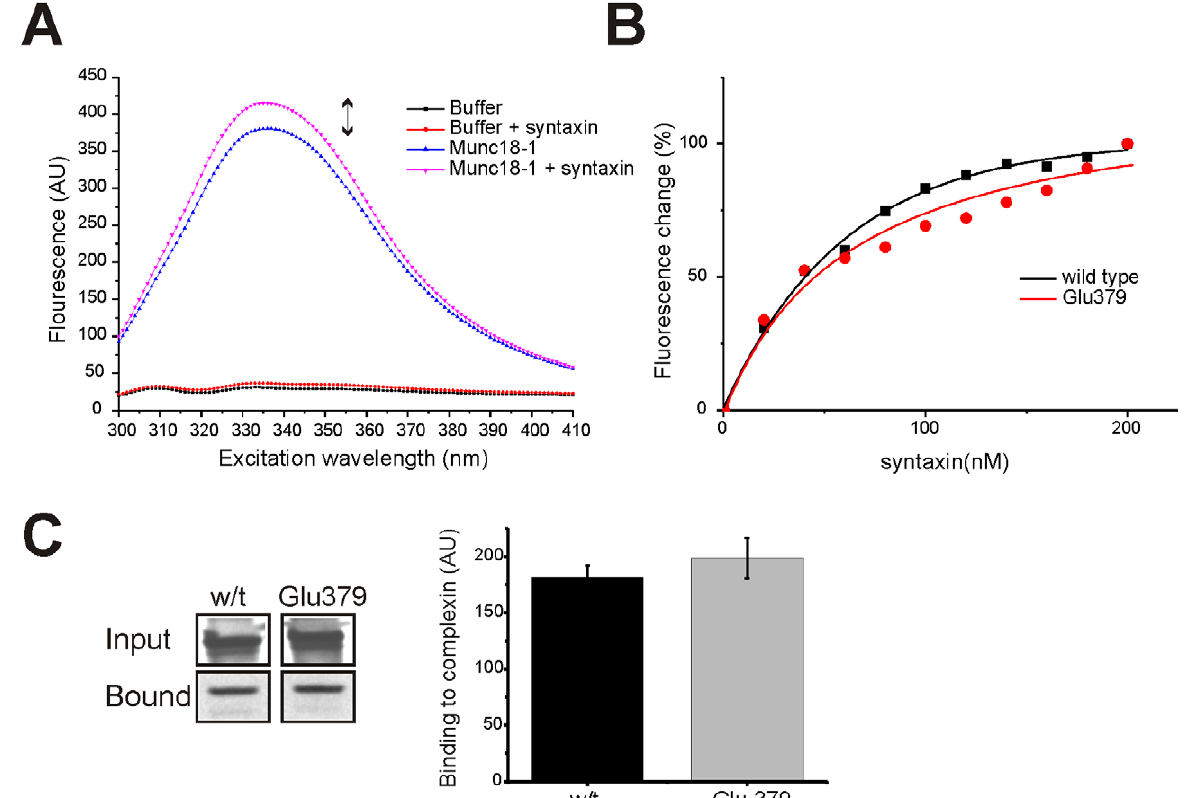
Figure 2. Lack of effect of the Glu379 mutation on the affinity of binding of Munc18-1 to closed syntaxin or on binding to the assembled SNARE complex. (A) Fluorescence emission spectra are shown of samples of buffer or buffer containing 100nM Munc18-1 with our without addition of 200 nM His 6 -syntaxin1A4-266. Addition of His 6 -syntaxin1A4-266 to Munc18-1 increased the peak fluorescence emission (indicated by the double-headed arrow). (B) Dose-dependent effect of addition of His 6 -syntaxin1A4-266 on peak fluorescence emission for wildtype and Glu379 Munc18-1. The data were fitted using non-linear curve fitting to a hyperbolic function. (C) A detergent-solubilized brain extract was incubated with GST-complexin immobilised on glutathione-Sepharose beads to pull down assembled SNARE complexes. In vitro translated, 35 S-radiolabelled, Munc18-1 wildtype and Glu379 were incubated with the loaded glutathione-Sepharose beads and bound radiolabelled protein remaining after washing and the corresponding inputs were analysed by SDS-PAGE followed by exposure to 35 S-sensitive film. The amount of bound radioactivity was assessed by quantitative densitometry (n=3) of Munc18-1 wildtype and Glu379 binding to the GST-complexin affinity-purified neuronal SNARE complex and corrected for the level of input protein. No difference was seen in the level of binding of wildtype and mutant